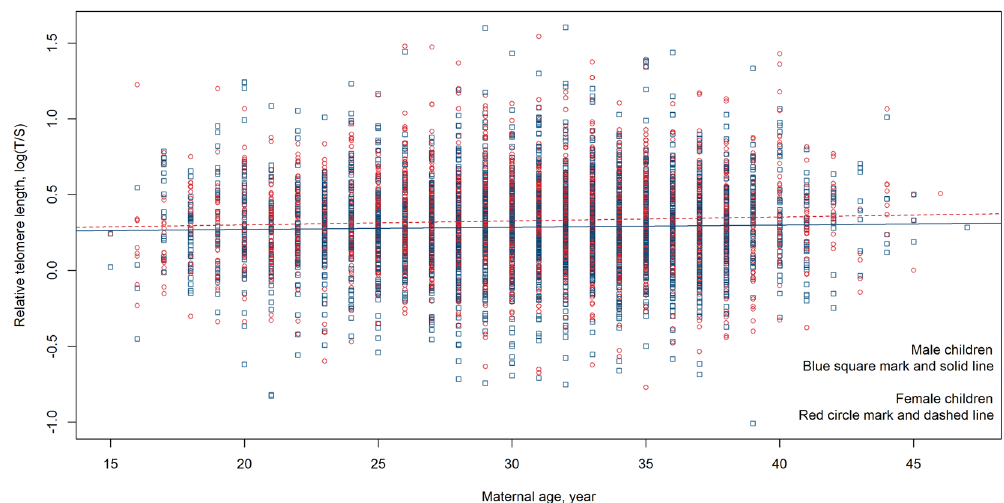
Figure 2. Relative telomere length expressed as log transformed T/S ratio versus maternal age. Male children: blue square mark and solid line; female children: red circle mark and dashed